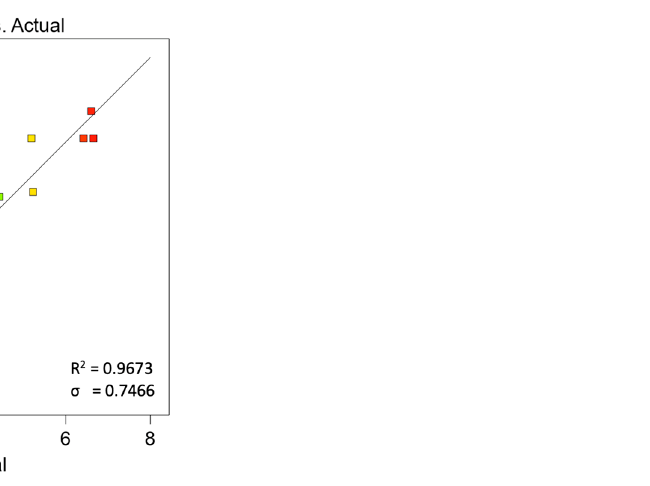
Table 3. Design matrix, experimental determined and predicted responses for the HER in seawater